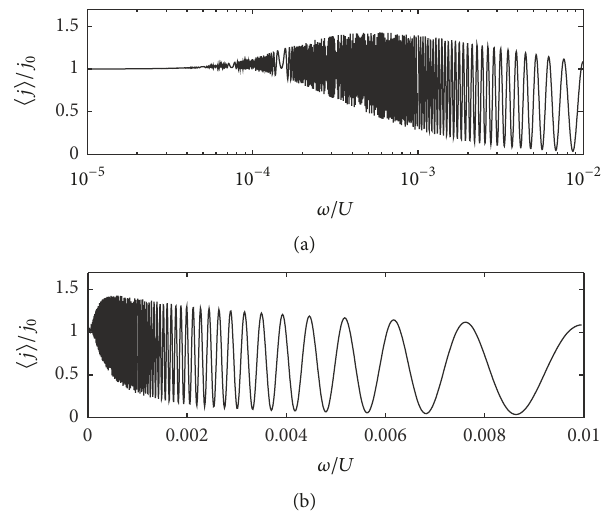
Figure 7: The ratio between the mean current and the stationary current as a function of the perturbation frequency in linear (b) and logarithmic (a) scales. The parameters are 𝐿√𝑈 = 6 , 𝑓 0 /√𝑈 = 0.5 , Ω/𝑈 = 0.5 , and Δ𝑓/√𝑈 = 1.2 . The adiabatic transition is approximately at 𝜔/𝑈 ∼ 10 −4